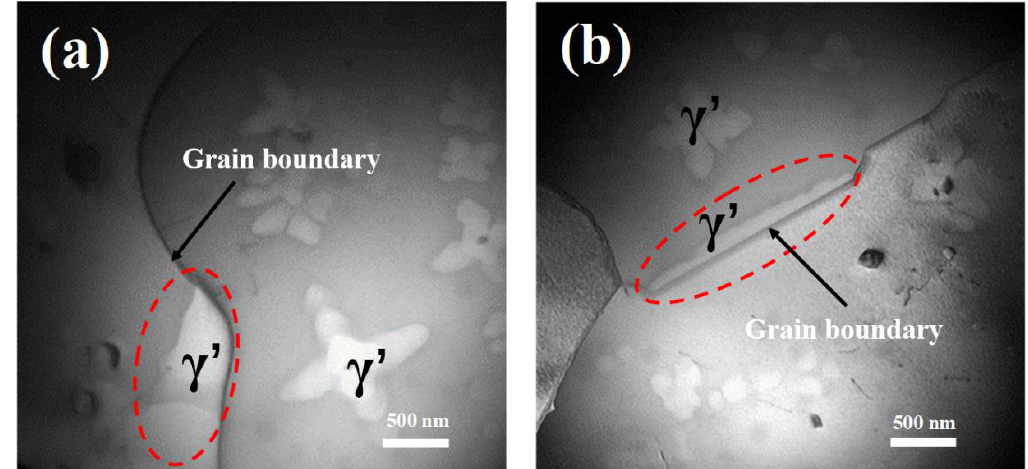
Figure 8. TEM images of FGH96 alloy (after cooling to 1000 °C with a cooling rate of 6 °C/min) exhibit γ’ precipitates in grain boundaries (marked by red dot circles) ( a ) the γ’ precipitate at the curving grain boundary; ( b ) the γ’ precipitate at the straight grain boundary.